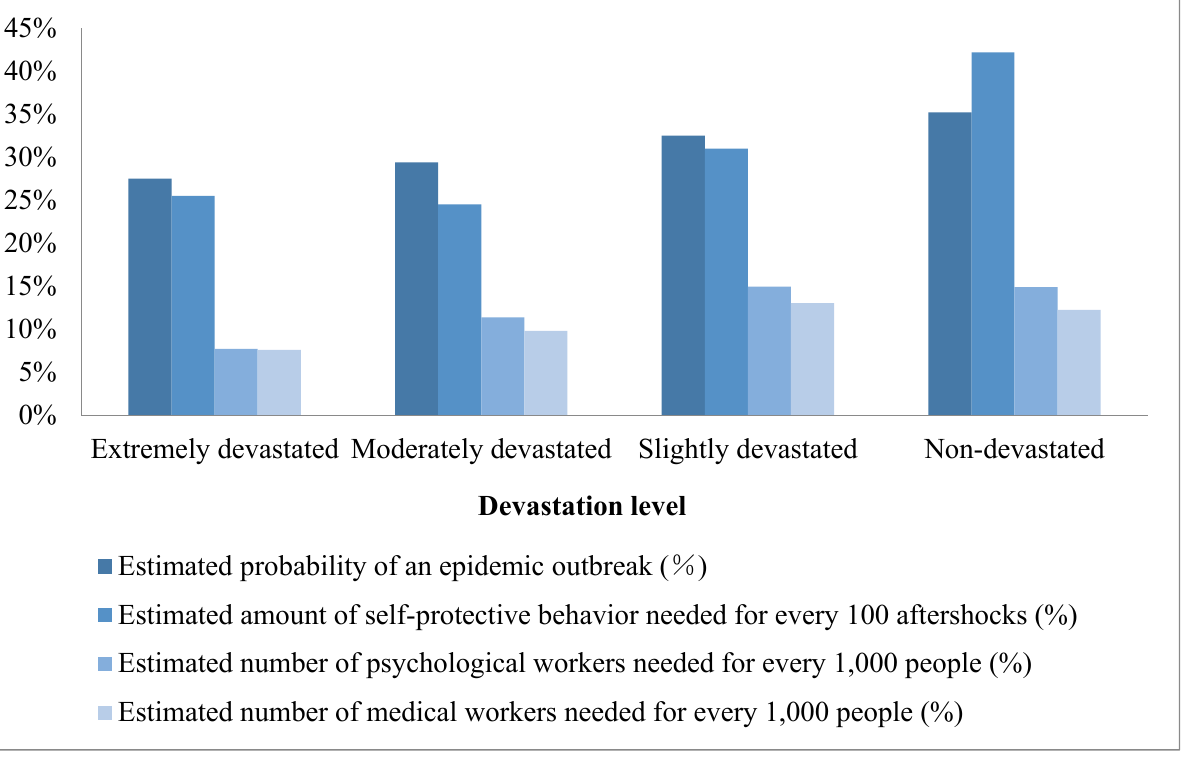
Figure 1. Residents’ post-earthquake concerns about safety and health issues in areas with varied devastation levels (replotted using the data of [4]).